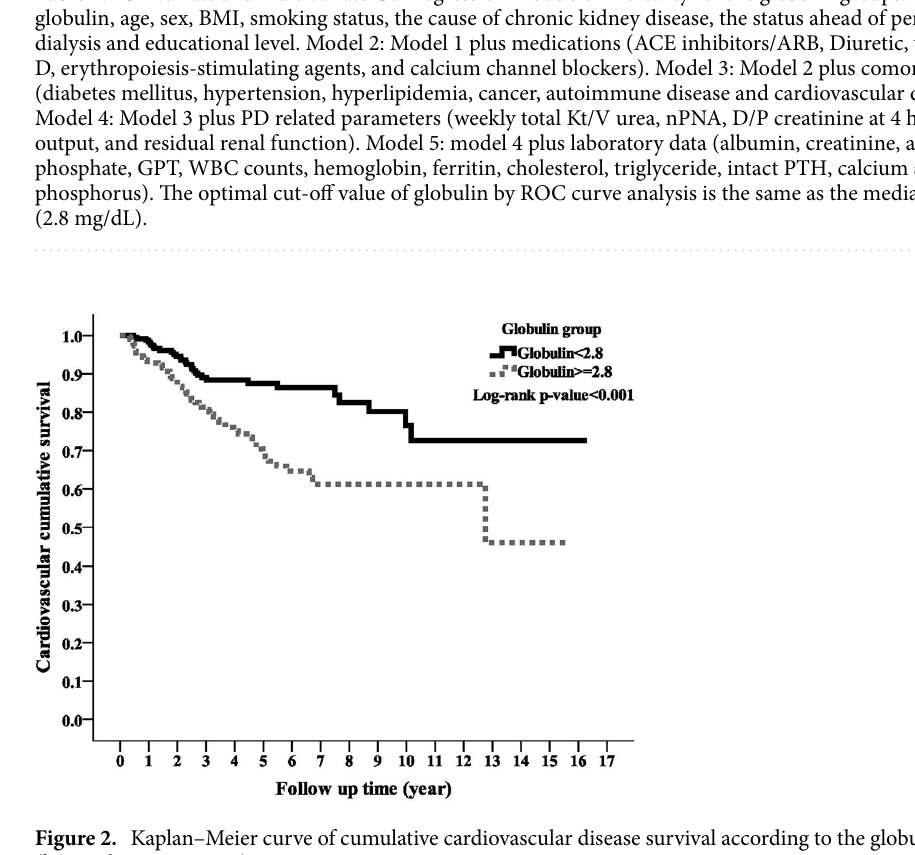
Figure 2. Kaplan–Meier curve of cumulative cardiovascular disease survival according to the globulin groups (log-rank test, p <